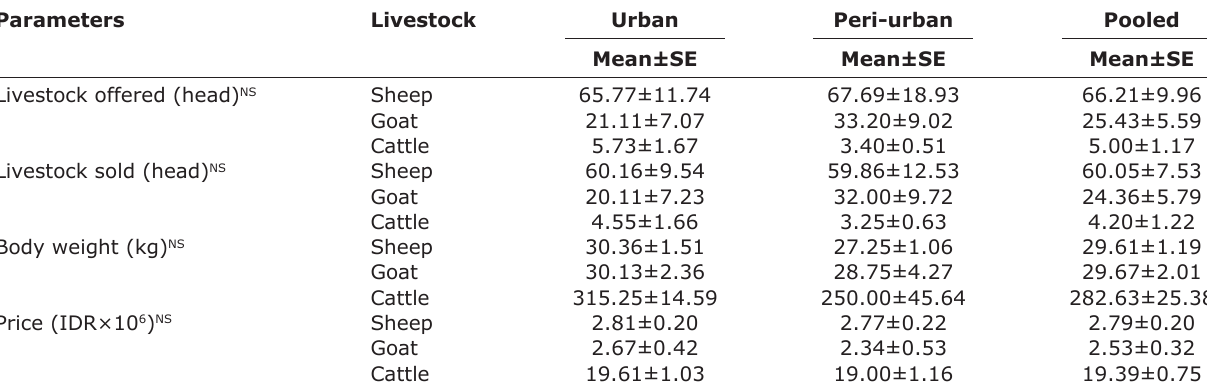
Table-5: Average number and price of livestock sold by roadside livestock traders during Eid al-Adha festival.